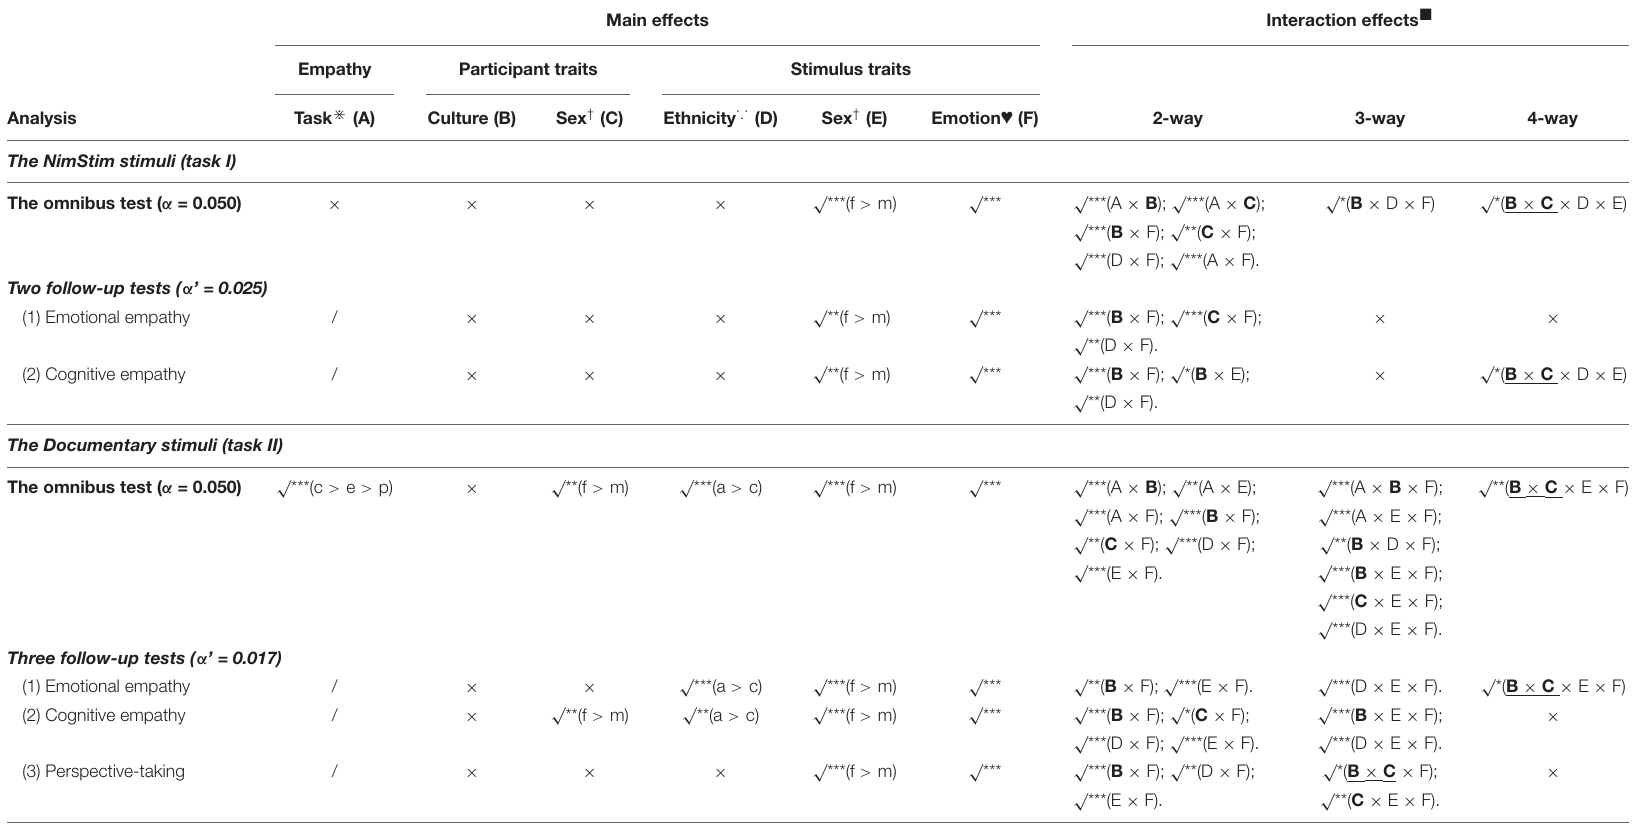
TABLE 5 | The main and interaction effects on state empathy for the NimStim stimuli (task I) and the documentary stimuli (task